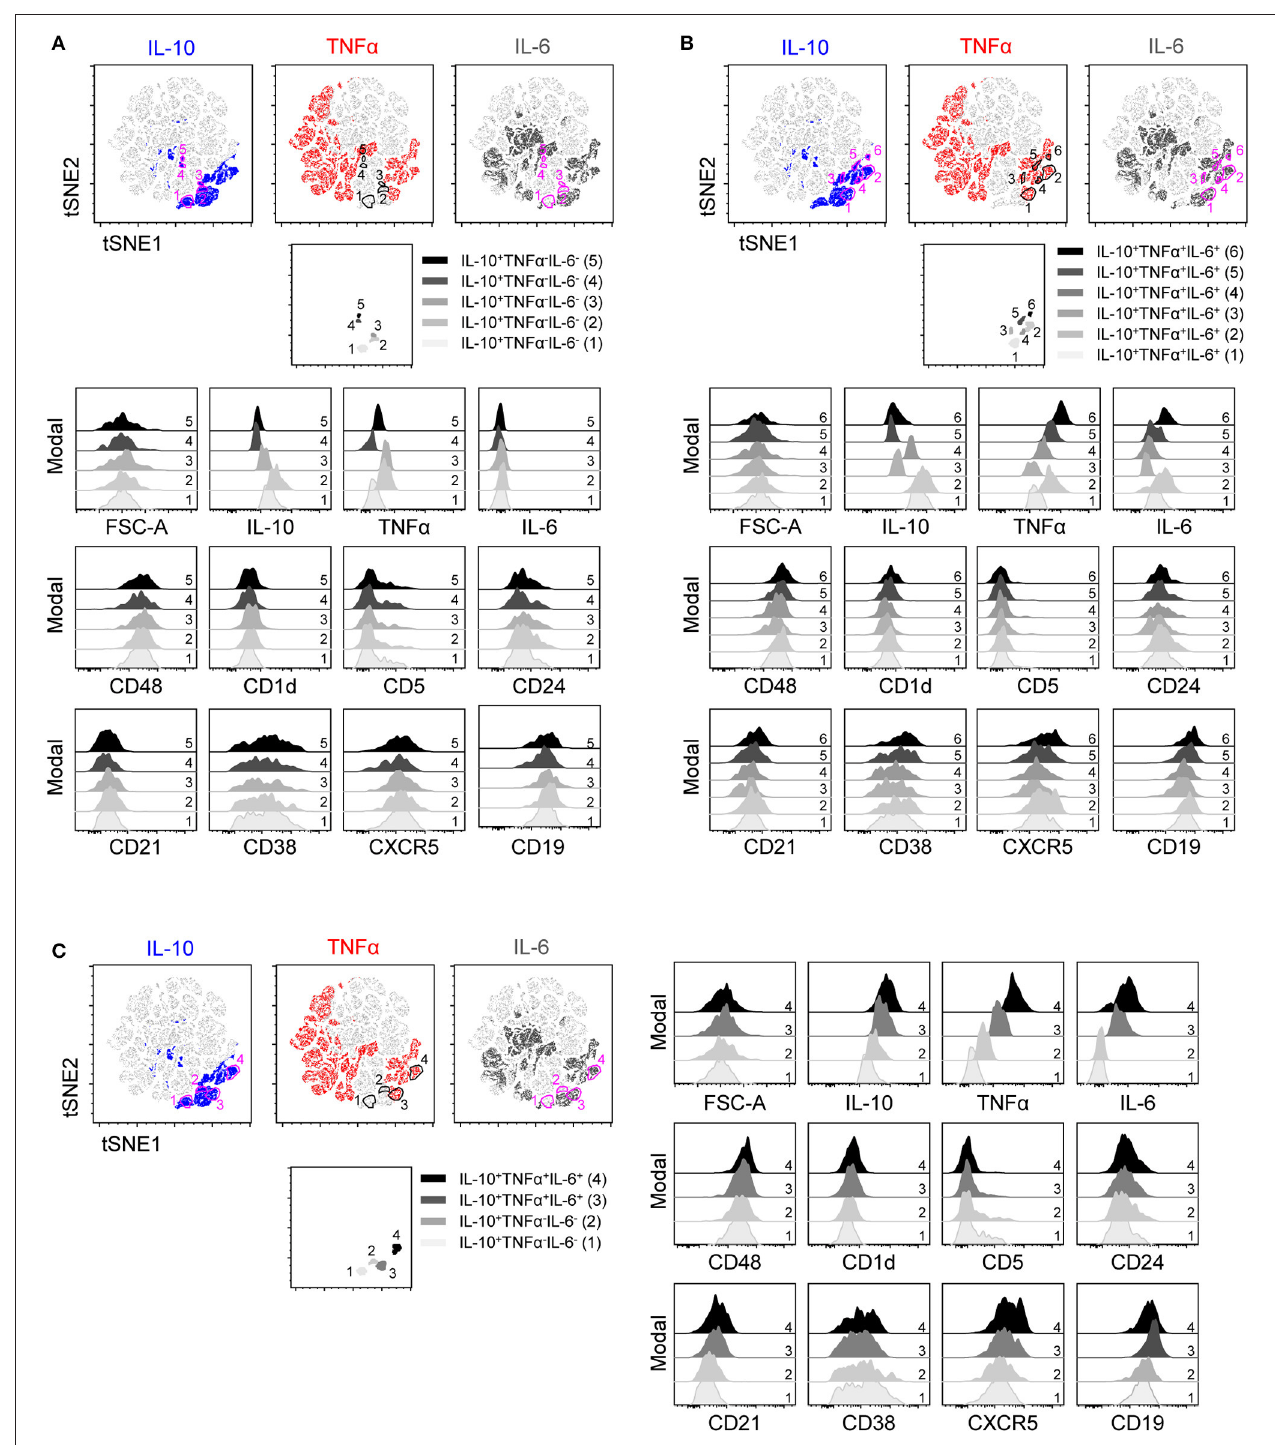
FIGURE 4 | t-SNE clustering on IL-10, TNF α , and IL-6 within B cells stimulated with CpG for 2 days and the expression of B reg associated markers. t-SNE 2D scatter plot of 91,000 living single CD19 + B cells stimulated for 2 days with CpG and stained with staining mixture 2 containing antibodies against IL-10, TNF α , IL-6, CD48, CD1d, CD5, CD24, CD21, CD38, CXCR5, and CD19 ( n = 7). t-SNE settings were as followed: perplexity 70; theta 0.5; eta 200 and iterations 1,000. IL-10, TNF α , and IL-6 were selected as t-SNE parameters. Different colors depict the IL-10 + (blue), TNF α + (red) and IL-6 + (dark gray) B cells. (A–C) Five IL-10 + TNF α − IL-6 − (A) , six IL-10 + TNF α + IL-6 + (B) and two IL-10 + TNF α − IL-6 − and IL-10 + TNF α + IL-6 + (C) B cells were gated within the t-SNE 2D scatter plot, selected populations are depicted in a separate t-SNE 2D scatter plot and expression of various markers within these populations (represented as color spectrum of gray and black) were depicted in half-off set histograms.